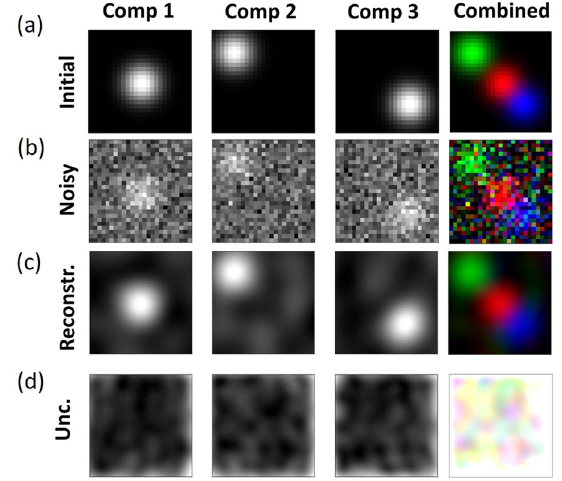
Fig. 4 Multivariate GP reconstruction of the 3-component data set. Shown is the ground truth data (top row), noise corrupted data for noise level σ = 0.3 (second row), reconstructed data resampled at four times the original grid density (third row), and reconstruction uncertainty (bottom row). The scale for all fi gures is [0, 1]. For combined images, each RGB component is displayed in its own scale [0,